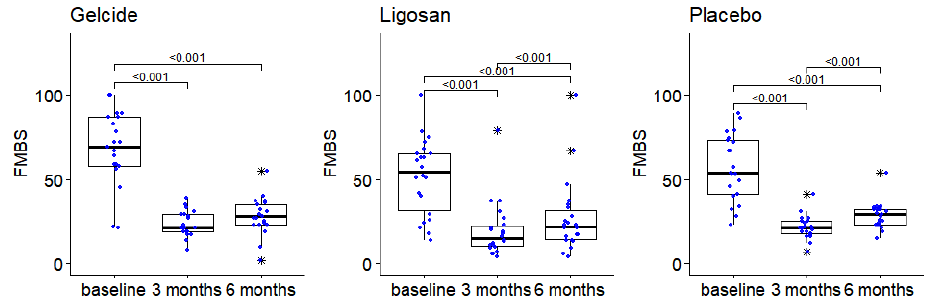
Figure 7. The evolution of the FMBS between successive time points in the three groups (numbers in brackets represent p -values of Wilcoxon tests for pairwise intragroup comparisons; p -values > 0.05 not displayed), boxplot depicts median and interquartile range, large stars represent outliers; data points displayed as superimposed dot plots.